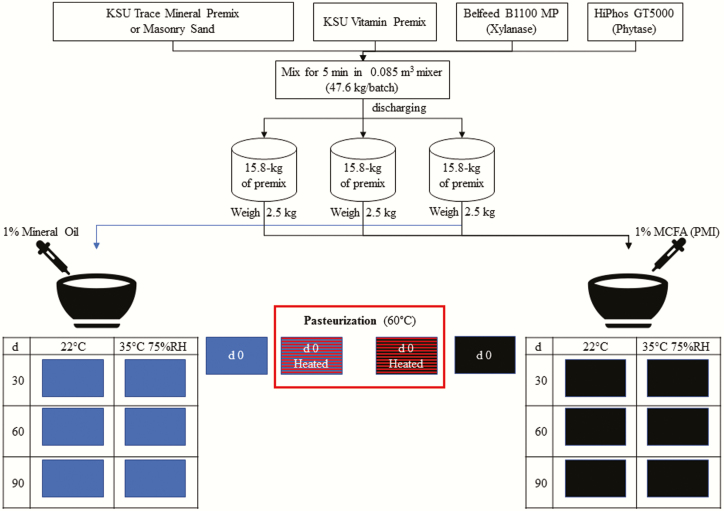
Flow chart of mixing steps used to create experimental treatments. Ingredients were mixed for 5 min in 47.6-kg batches using a 0.085-m3 paddle mixer (Davis model 2014197-SS-S1, Bonner Springs, KS). Then, each premix was equally discharged into three separate 15.9-kg aliquots. A 2.5-kg subsample of each aliquot was taken to create a 7.5-kg experimental premix treatment. The 7.5-kg premixes were mixed for 10 s using a mixer (Hobart model HL-200, Troy, OH). Following the 10-s dry mix, either a 74.8 g of 1:1:1 commercial blend of C6:0, C8:0, and C10:0 medium-chain fatty acids (MCFA; PMI Nutritional Additives, Arden Hills, MN) or 74.8-g of mineral oil (MO) was added using a pressurized hand-held sprayer with a fine hollow cone spray nozzle (UNIJET model TN-SS-2, Wheaton, IL). The premixes were mixed for an additional 90 s after oil application. The mixed samples were divided to obtain eight individual 900-g samples, which were placed in single-lined paper bags. Samples were then stored at room temperature in a temperature-controlled laboratory (approximately 22 °C) or in an environmentally controlled chamber (Caron model 6030, Marietta, OH) set at 40 °C and 75% relative humidity (RH). In addition, separate samples were heated in an environmentally control chamber (Caron model 6030, Marietta, OH) at 60 °C and 20% RH.